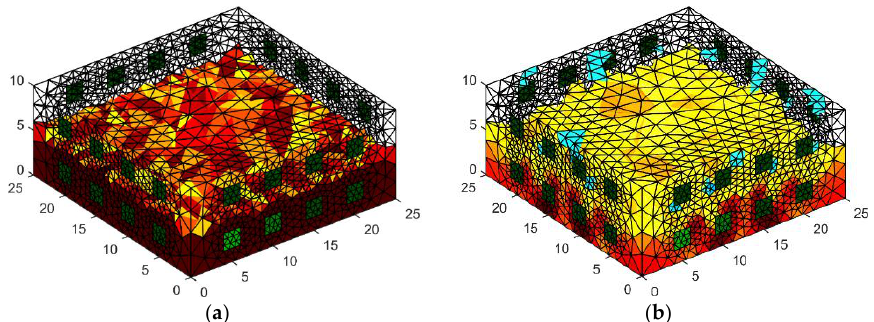
Figure 9. The geometrical model 3D with 4 × 8 electrodes—the image reconstruction: ( a ) pattern model, ( b ) Gauss-Newton method with Laplace regularization.